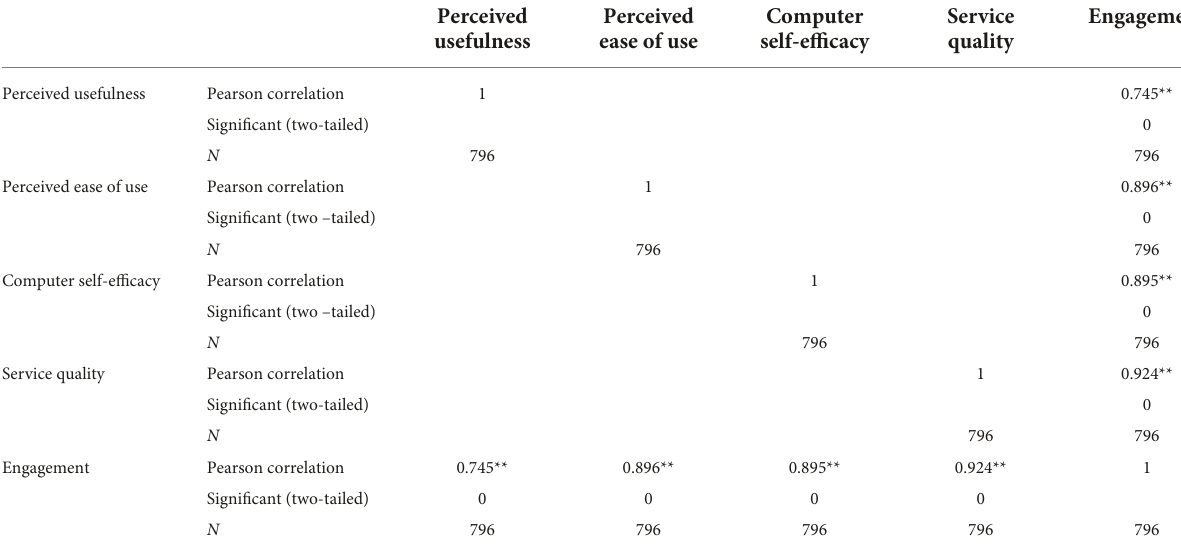
TABLE 5 Pearson correlation analysis between the factors influencing blended learning and level of student